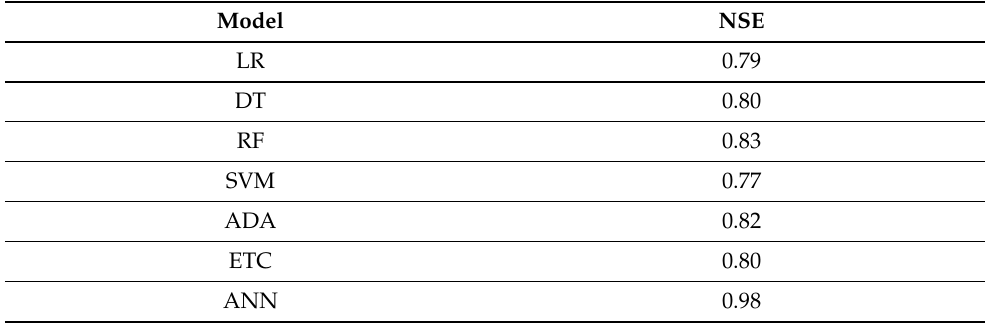
Table 12. NSE values for water consumption prediction.